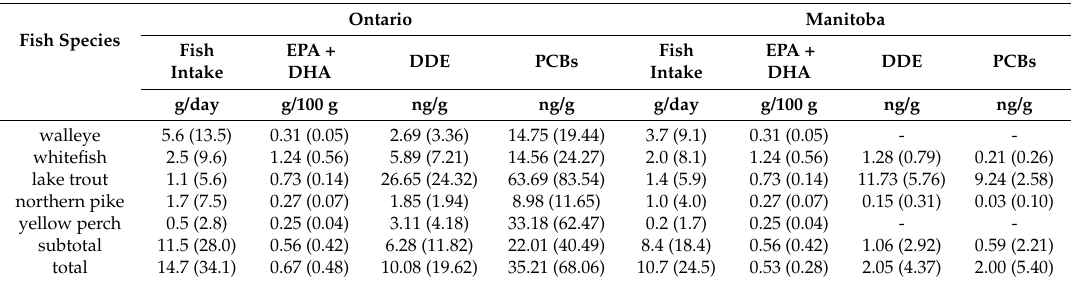
Table 2. EPA + DHA and persistent organic pollutant (POP) concentrations in the top five fish species in Ontario and Manitoba First